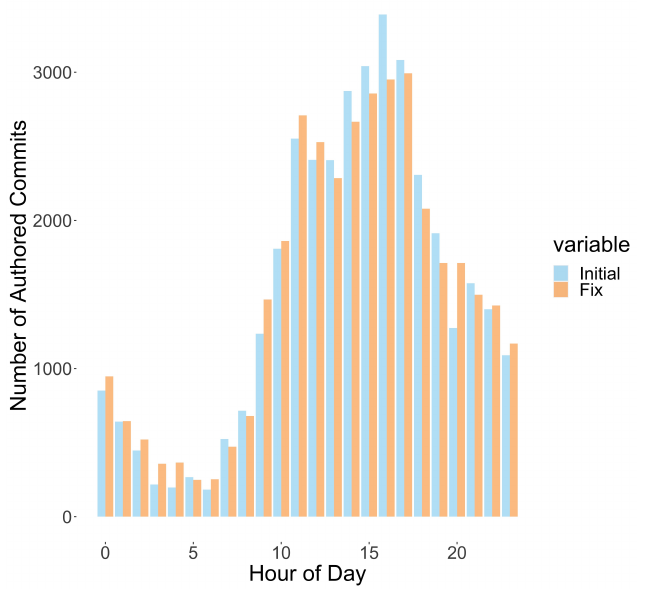
Figure 2. Buggy commits made per hour.